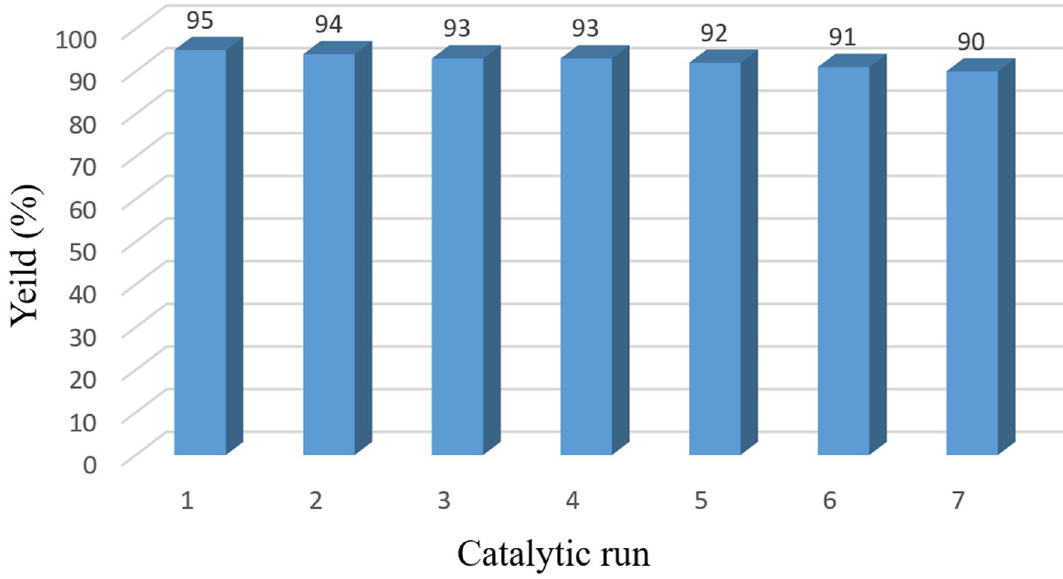
Figure 11. Recycling diagram of the guanidinylated SBA-15/Fe 3 O 4 mesoporous catalyst in the synthesis of 5e